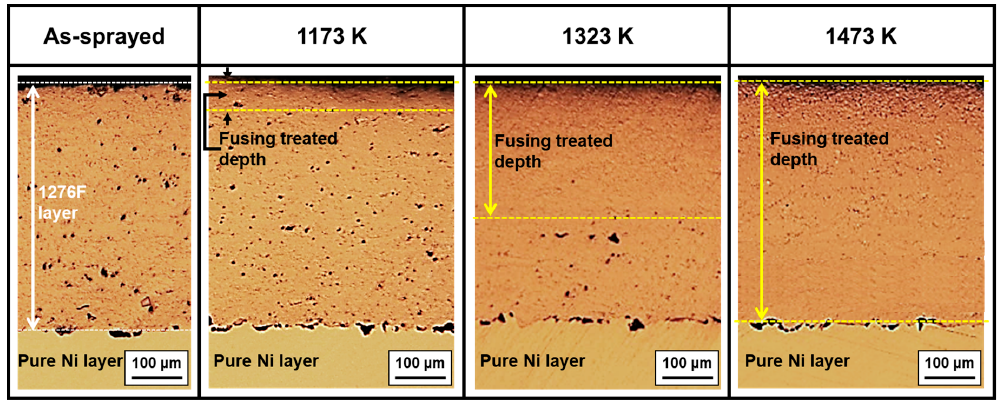
Figure 5. Variation in cross-sectional macrostructure as a function of fusing treatment temperature.